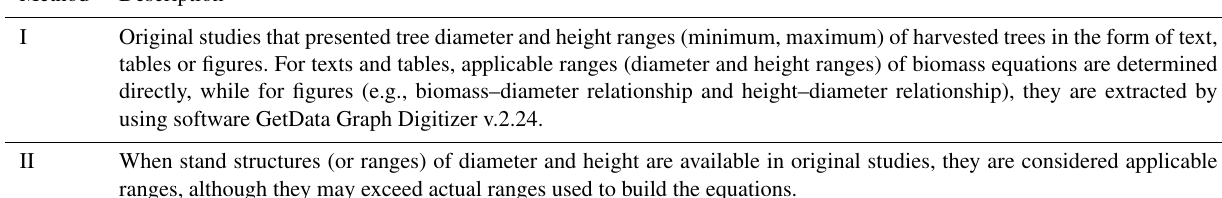
Table 2. Methods for determining applicable ranges of biomass equations ∗ . Method